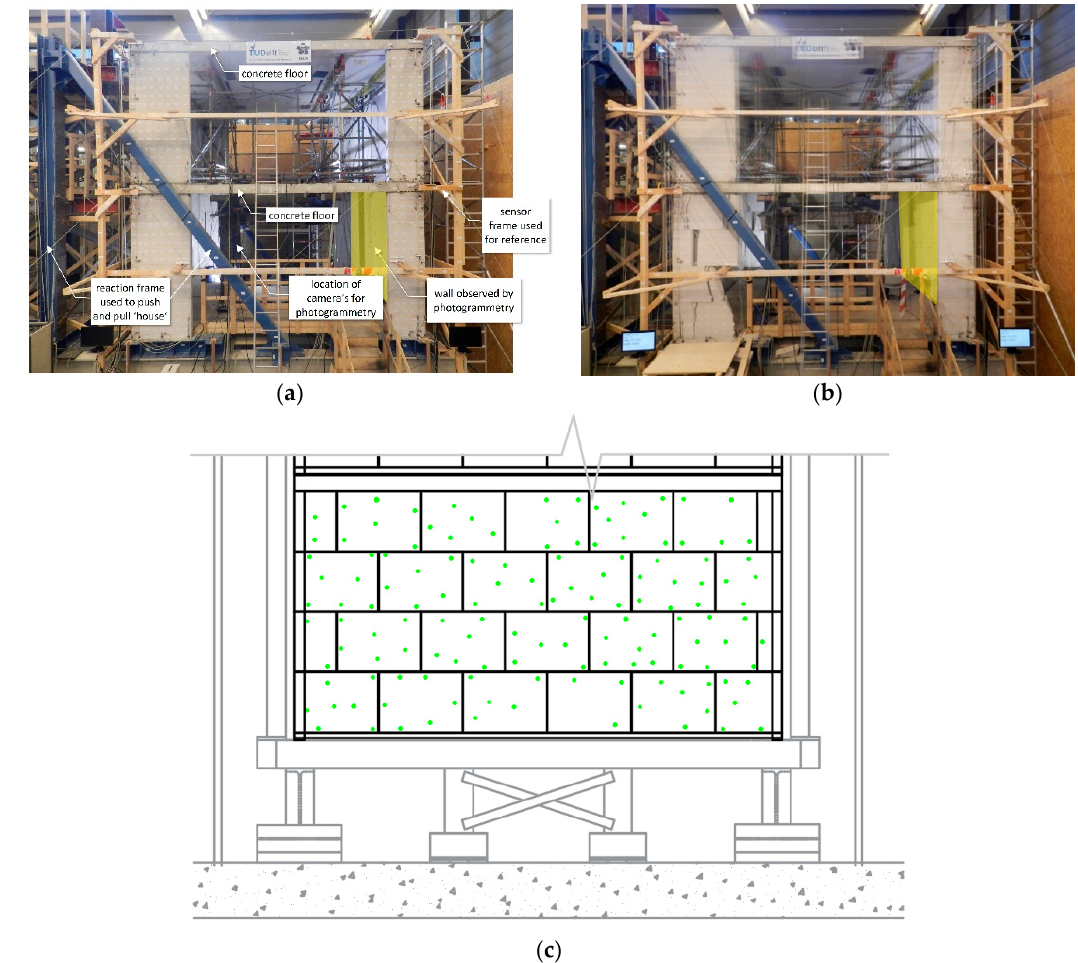
Figure 2. Front view from the south of the masonry structure in the test set-up for the quasi-static cyclic test: ( a ) detailed view of the south part; ( b ) impression of the deformation of the structure under horizontal load obtained by showing the extreme displacement in the east and west directions in one image. The extreme east–west displacement of the top concrete floor of the house was approximately 100 mm.